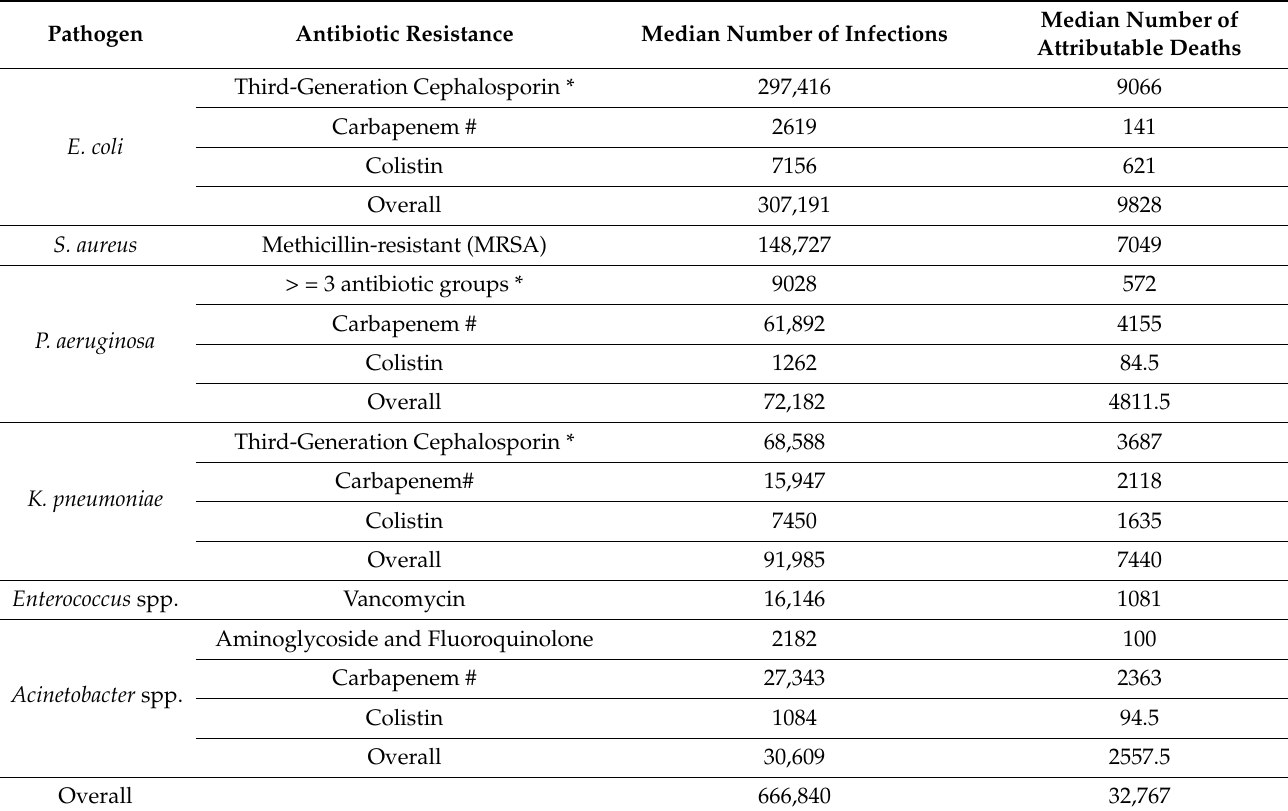
Table 1. Median number of multi-drug resistance pathogen infections and deaths in the European Union during 2015. Adapted from Cassini et al. [2].